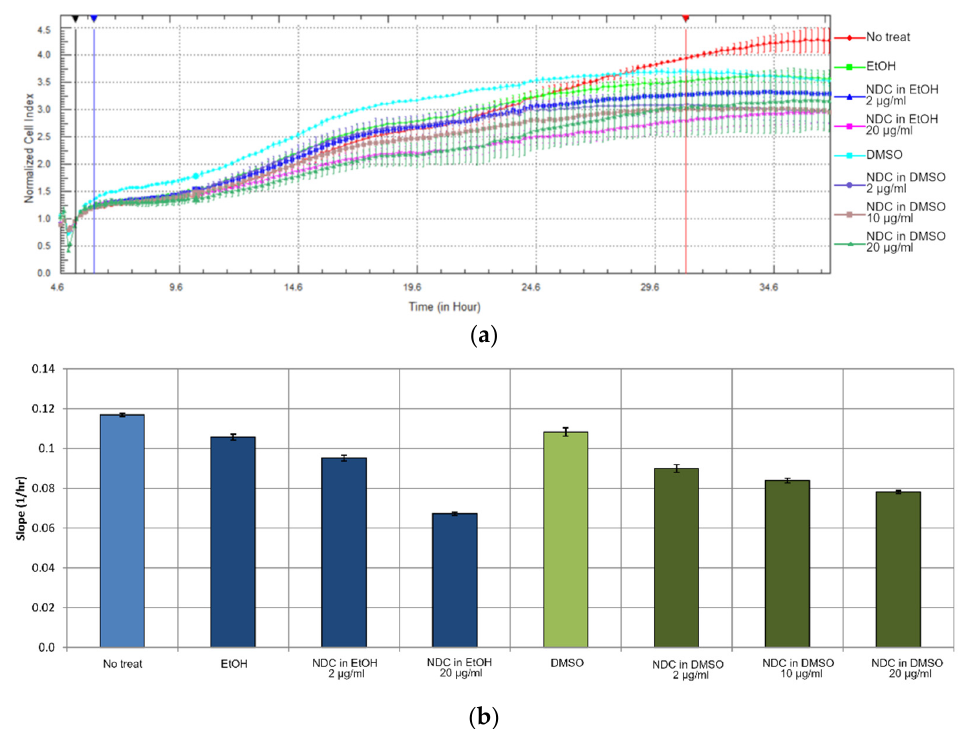
Figure 5. Real-time cell analysis. ( a ) Impedance-based cell growth curves. ( b ) Cell proliferation rate estimated by the growth curve slope